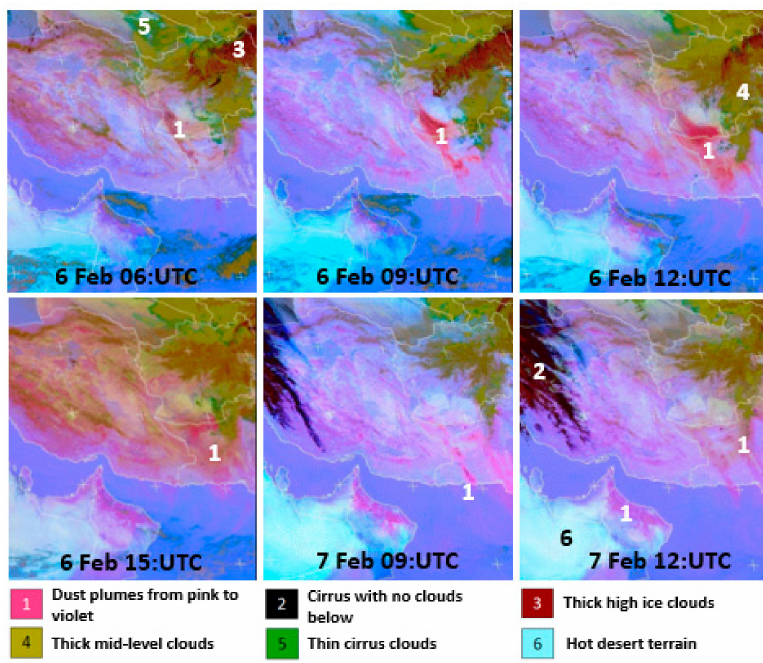
Figure 2. Meteosat (Spinning Enhanced Visible and Infrared Imager) SEVIRI imagery on 6 February 2019 (06:00, 09:00, 12:00, 15:00 UTC) and on 7 February 2019 (09:00, 12:00 UTC). The dust plumes appear in pink and violet in these composite